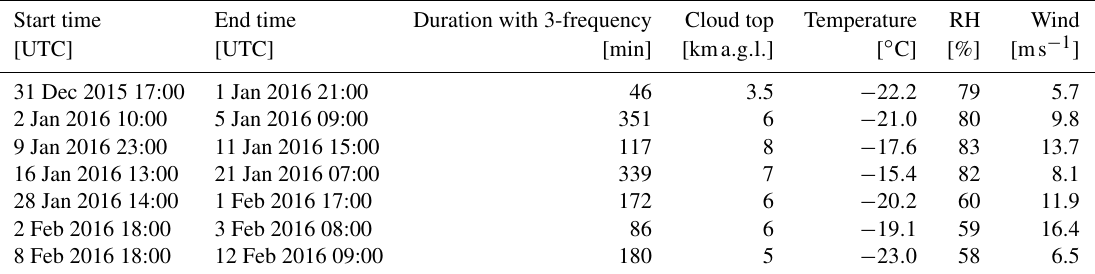
Table 1. List of AWARE cases with triple-frequency radar observations and corresponding mean environmental variables. Temperature and wind are averages over the 0–5kma . g . l . layer obtained from radiosonde measurements. Relative humidity is measured with an ARM surface meteorological station. Start time End time Duration with 3-frequency Cloud top Temperature RH Wind [UTC] [UTC] [min] [kma . g . l . ] [ ◦